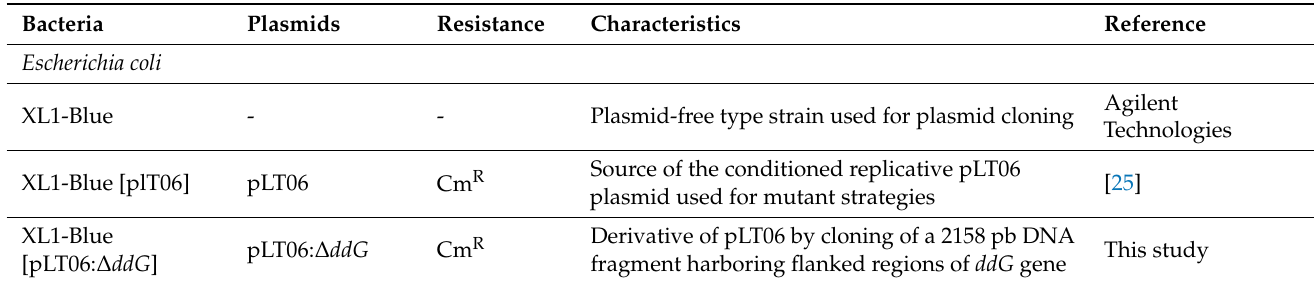
Table 1. List of the bacteria used in this work. Resistance Characteristics Reference Plasmid-free type strain used for plasmid cloning